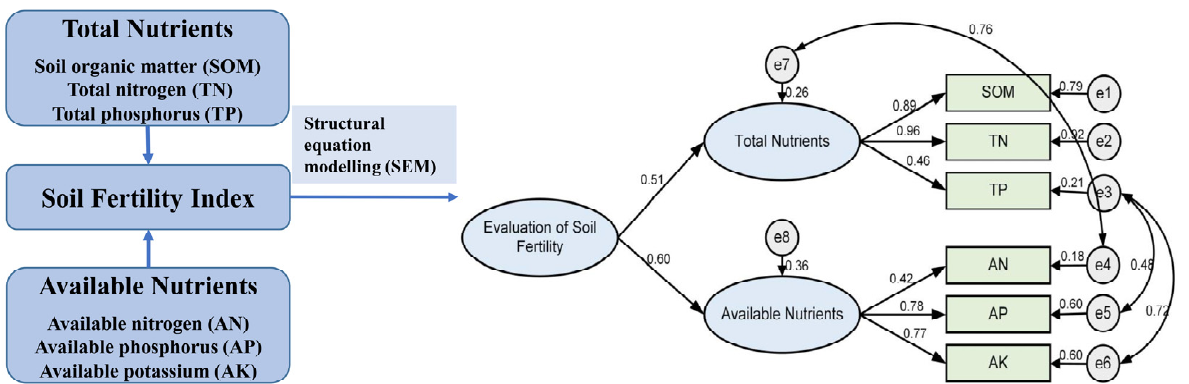
Figure 2. Modified model for the evaluation of soil fertility.